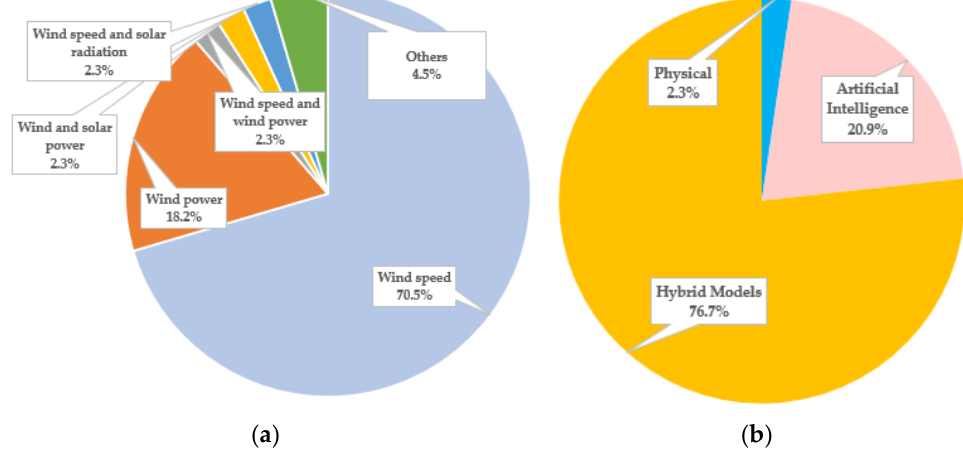
Figure 8. ( a ) Percentage distribution of the forecast objective of the very short-term models. ( b ) Per- centage distribution of very short-term forecasting methods.